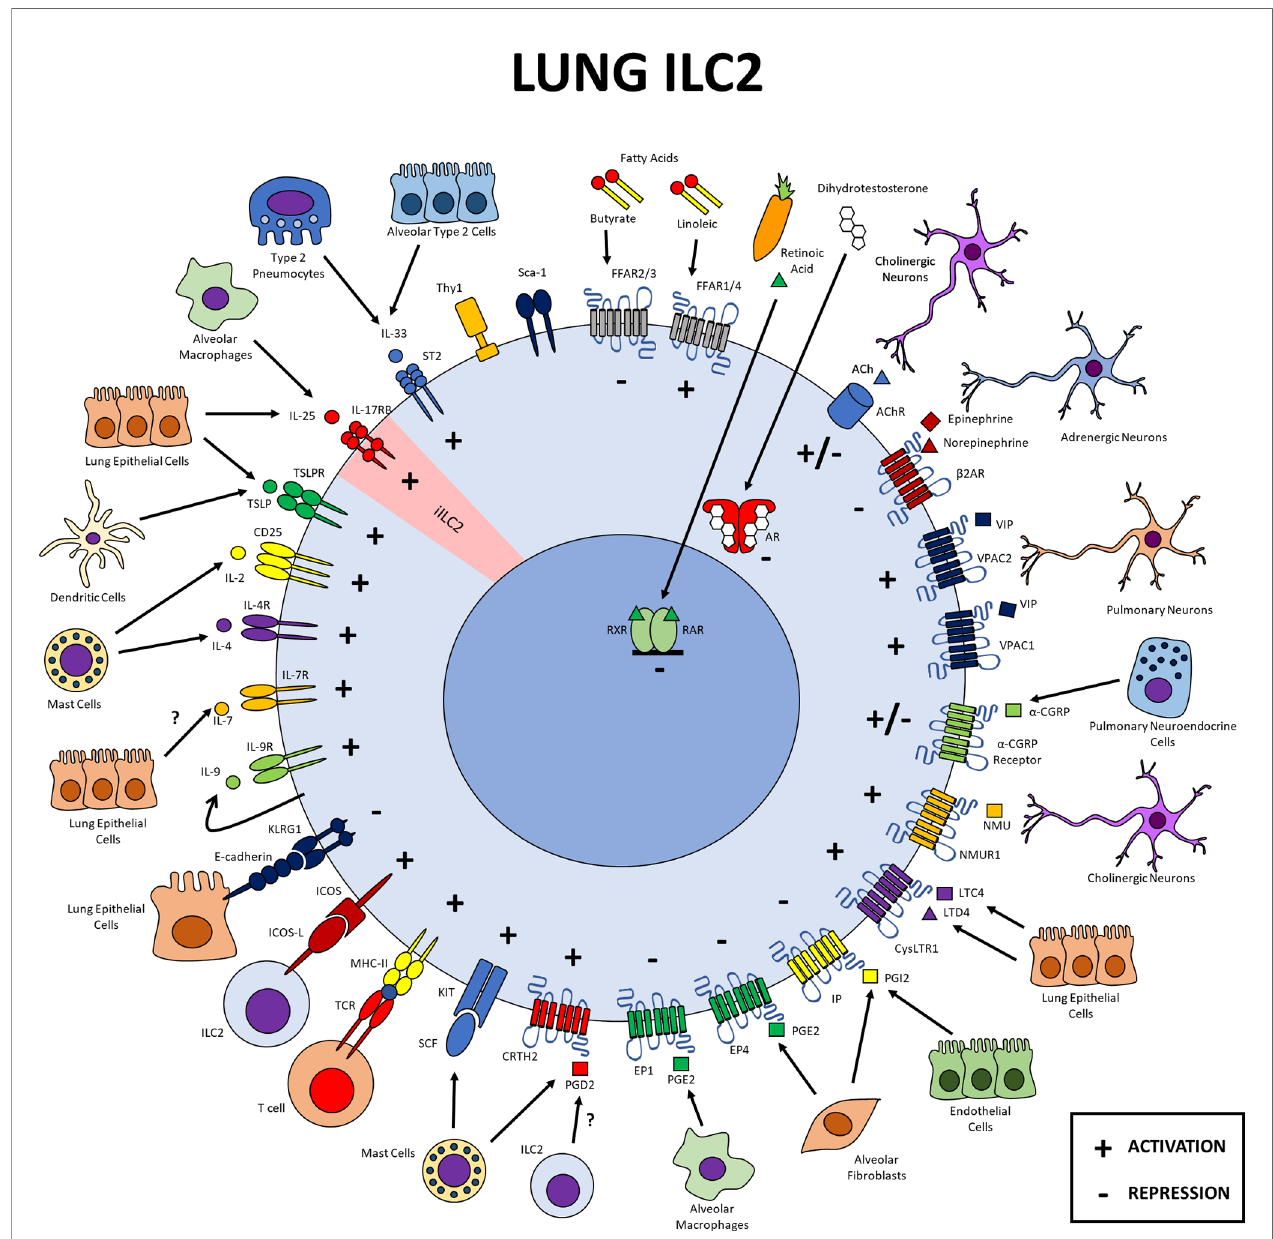
FIGURE 1 | Lung ILC2s. Expression of different markers on pulmonary ILC2s and possible cellular interactions within this tissue. Lung ILC2s interact with the epithelium and different cell populations of the immune and the nervous systems. Cytokine receptors transduce signals that activate ILC2s, as does the immune checkpoint molecule ICOS and MHCII. Lipid mediators PGD2, LTC4 and LTD4 induce positive signals in ILC2s while PGE2 and PGI2 negatively regulate their function. The neuropeptides NMU and VIP positively regulate ILC2s while catecholamines drive a negative regulation and CGRP and ACh displays a dual function. Dihydrotestosterone and Klrg1 repress lung ILC2s. Diet derived factors like retinoic acid and butyrate inhibit ILC2 function while linoleic promotes it. iILC2 in fl ammatory ILC2, SCF stem cell factor, PG, prostaglandin; LT, leukotriene; NMU, neuromedin U; CGRP, calcitonin gene related peptide; VIP, vasoactive intestinal peptide; ACh, acetylcholine; RAR, retinoid acid receptor; RXR, retinoid X